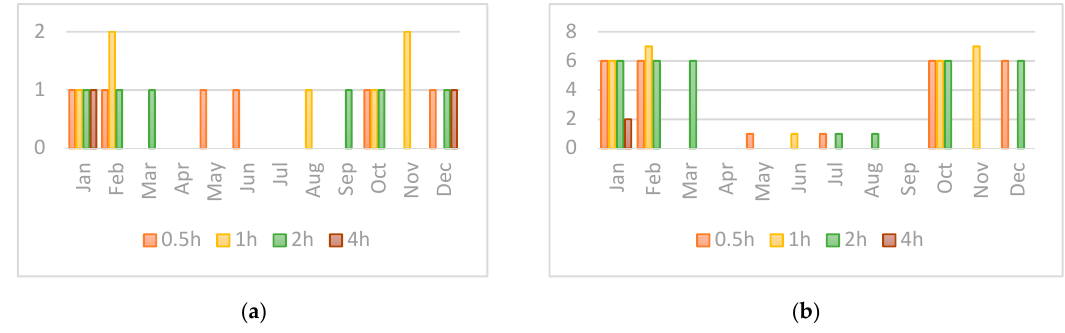
Figure 2. The number of stress events in the capacity market used in this study ( a ) scenario 1; ( b ) scenario 2.